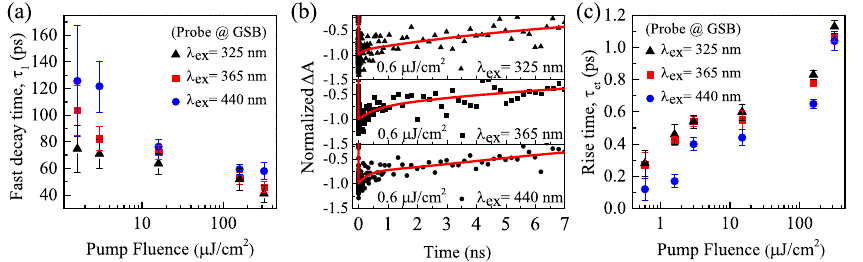
Figure 5. ( a ) Decay time constant of fast decay component the GSB dynamic as a function of pump fluence with 325 nm, 365 nm, and 440 nm pump wavelengths. ( b ) Single-excitons recombination lifetimes with 325 nm, 365 nm, and 440 nm at 0.6 µ J/cm 2 , and ( c ) rise-time constant of the GSB dynamic as a function of pump fluence with 325 nm, 365 nm, and 440